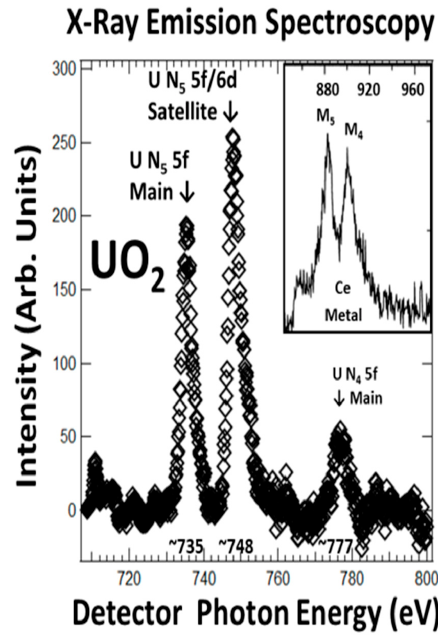
Figure 5. Main: presented here are the XES peaks for the N 4,5 transitions in UO 2 . A peak fitting of the features with asymmetric Gaussian functions produces an area ratio of 8.9 between the sum of the two N 5 peaks and the N 4 peak, similar to the peak height ratio of 9 for these same features. Inset: the M 4,5 XES of Ce metal is shown here.